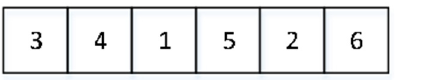
Figure 4. Chromosome representing the order of jobs.